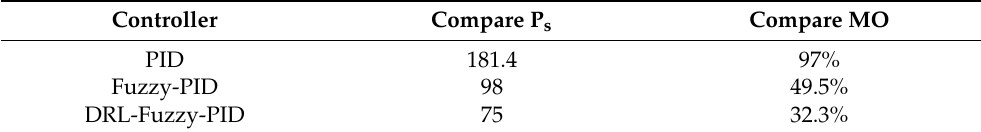
Figure 13. Position comparison diagram of DRL-Fuzzy-PID, Fuzzy-PID, and PID control in step response. Table 3. Results of conventional PID, Fuzzy-PID, and DRL-Fuzzy-PID control in step response.